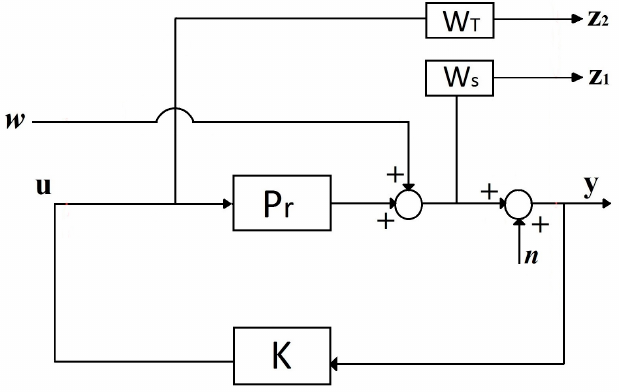
Figure 2. Augmented system structure.